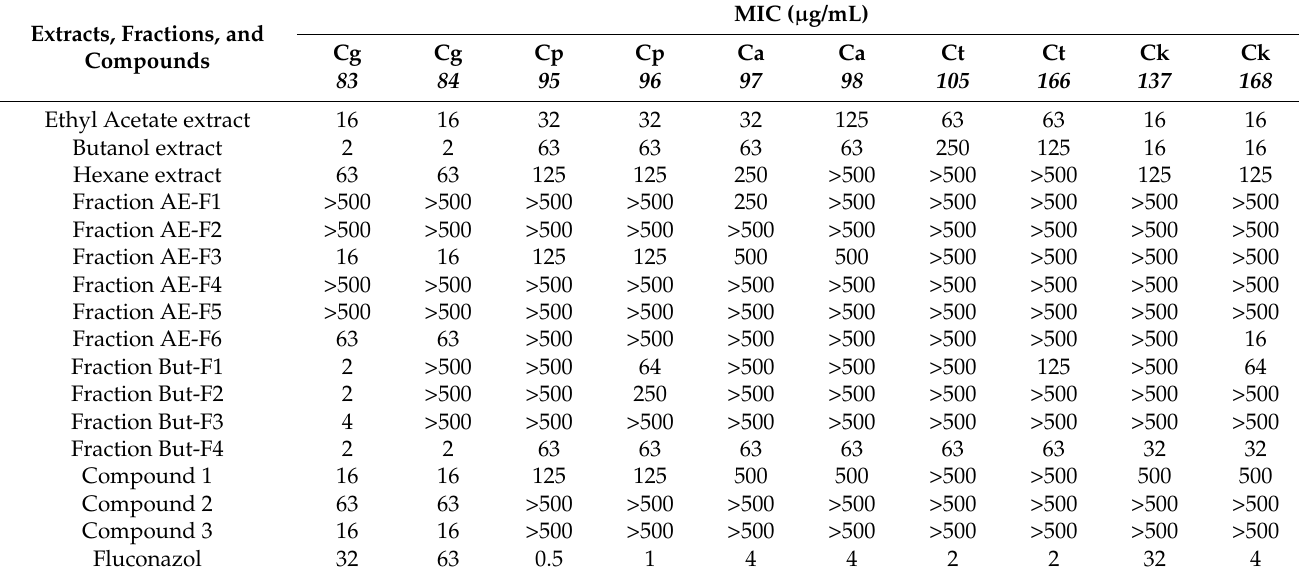
Table 1. Antifungal activity of fractions and compounds obtained from the aerial parts of C. greggii var greggii . Extracts, Fractions, and